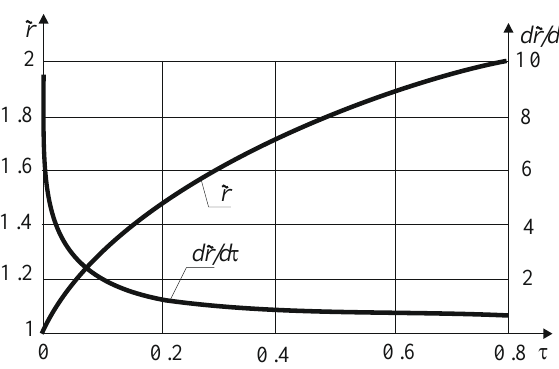
Figure 3. The dependence on the position of the solidification front and the solidification rate on time in an annular space for an unheated liquid (𝑠 = 0.5,𝐵 = 0, 𝐵𝑖 𝐶𝑂𝑁 = 10, 𝐵𝑖 𝐶 = 177) .